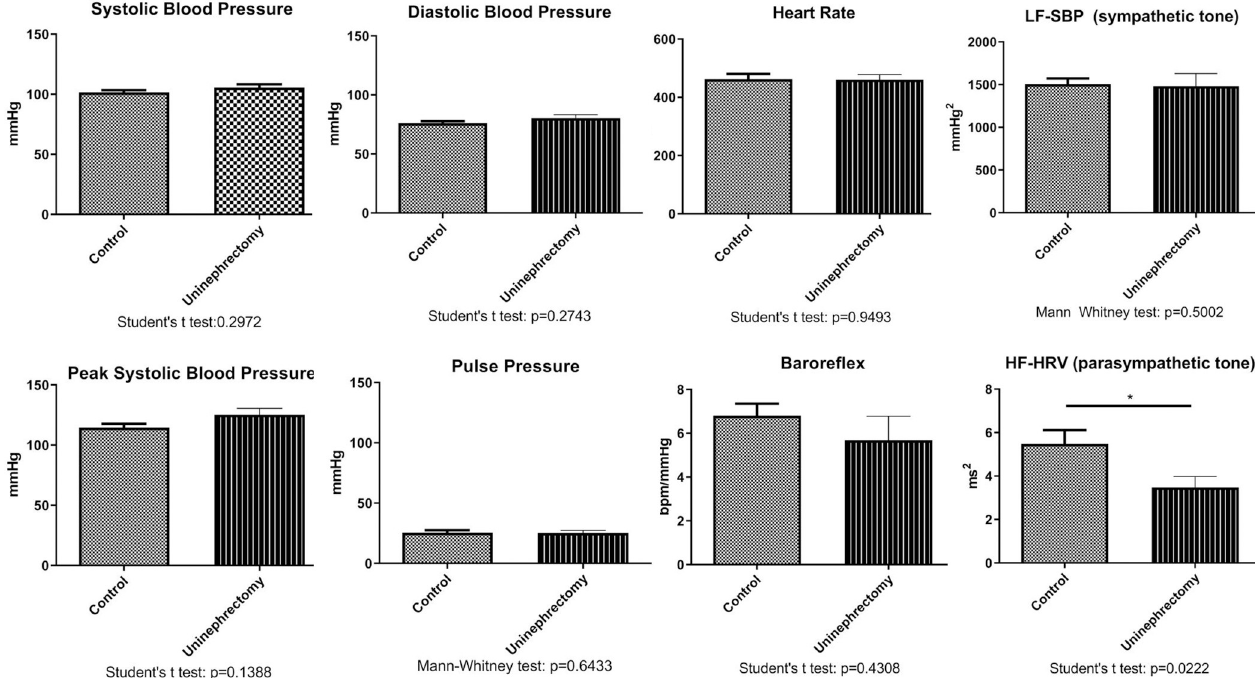
Fig 2. Hemodynamic data (mean and peak systolic, diastolic, pulse pressure, heart rate) and powerspectral-analysis data low-frequency band of powerspectrum of systolic blood pressure (LF-SBP) as a measure of sympathetic modulation of vascular tone, high-frequency band of powerspectrum of heart rate (HF-HR) as a measure of parasympathetic modulation of sinus node function and baroreflex-sensitivity data of sham-operated C57BL/6n mice (controls, n = 8) and unilaterally nephrectomized C57BL/6n mice (n = 15).